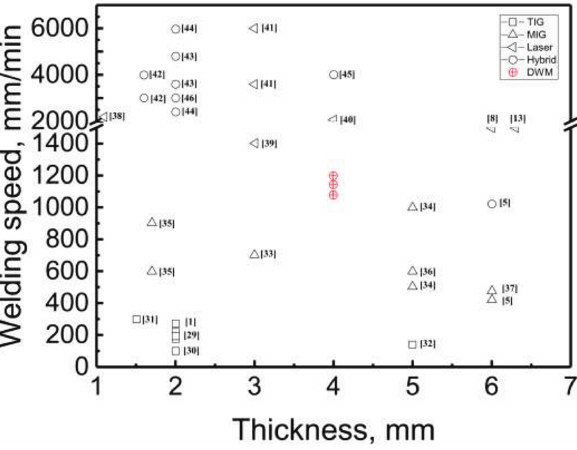
Figure 12: Comparison of welding speeds for aluminum alloys of varying thicknesses using different fusion welding methods [1, 5, 8, 13, 29 –